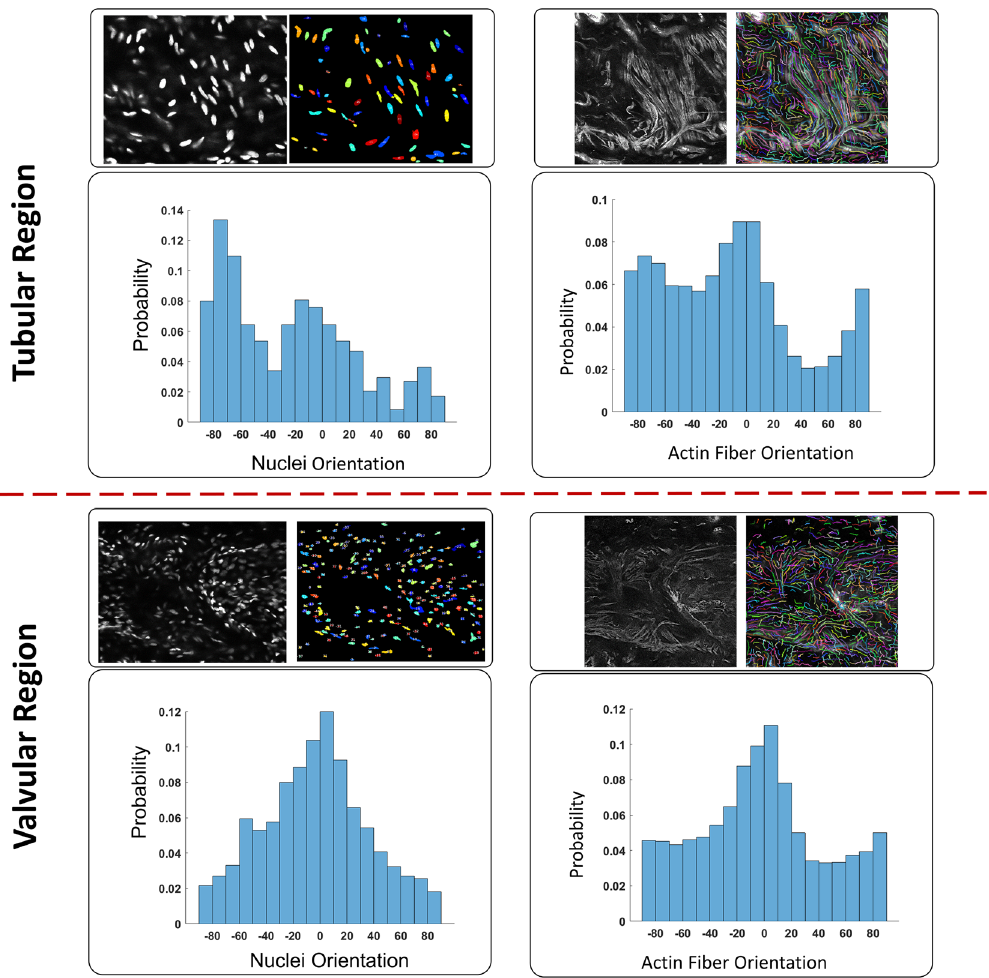
Figure 6. Histograms of nuclei obtained for tubular and valvular regions ( n = 5) from DAPI staining represented in Fig. 5. The axial direction corresponds to 0° and the circumferential direction corresponds to ± 90°.